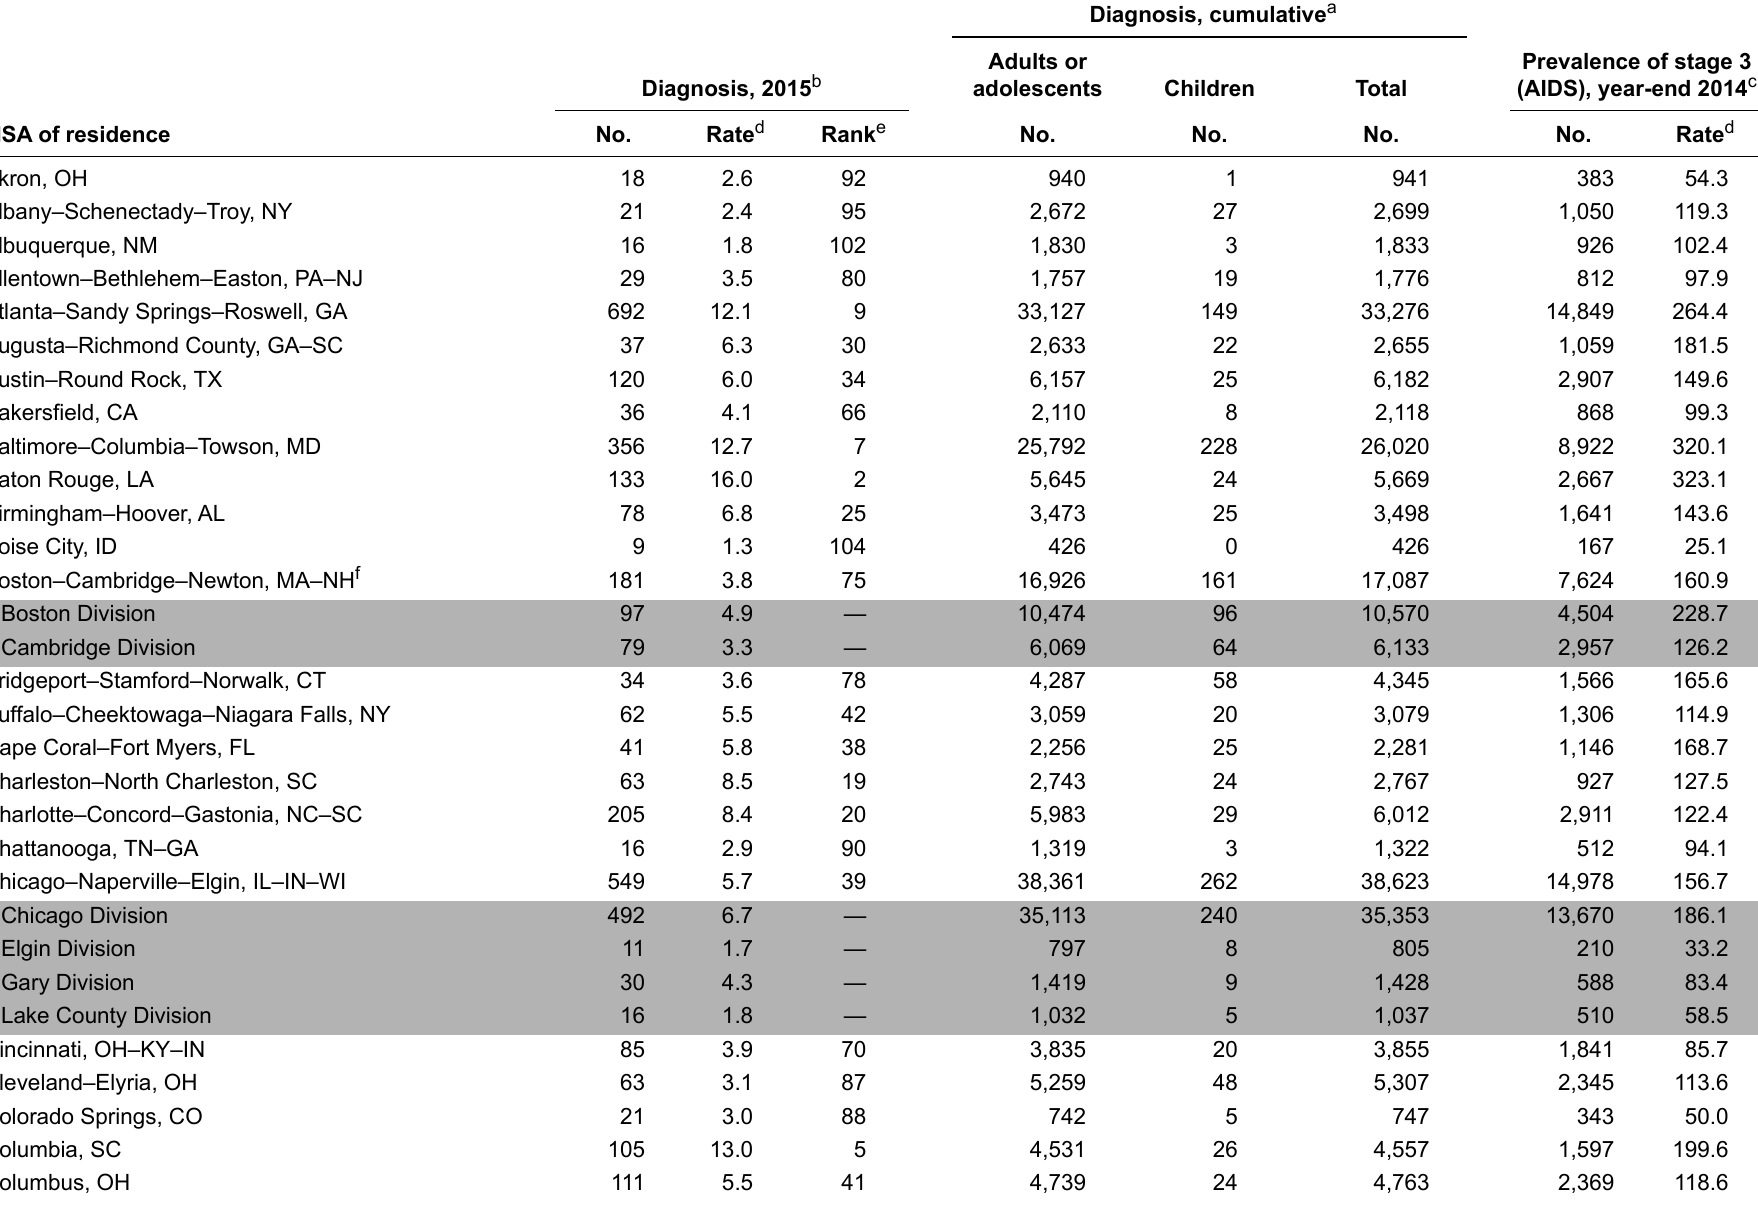
Table 27. Stage 3 (AIDS), 2015 and cumulative, and persons living with diagnosed HIV infection ever classified as stage 3 (AIDS) (prevalence), year-end 2014, by metropolitan statistical area of residence—United States and Puerto Rico Diagnosis, cumulative a Prevalence of stage Diagnosis, 2015 b